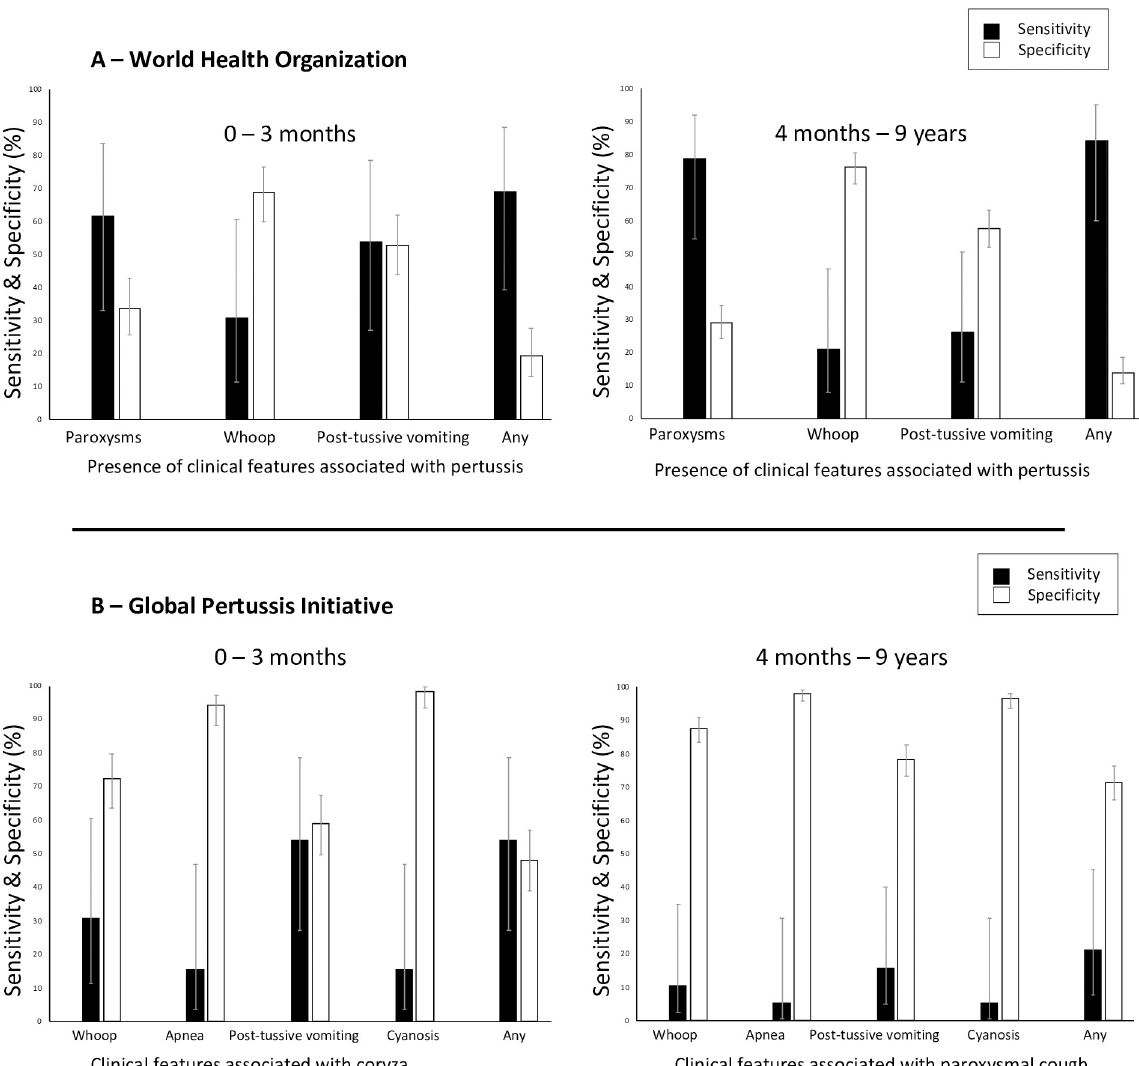
Fig 1. Sensitivity and specificity of clinical features in the diagnosis of